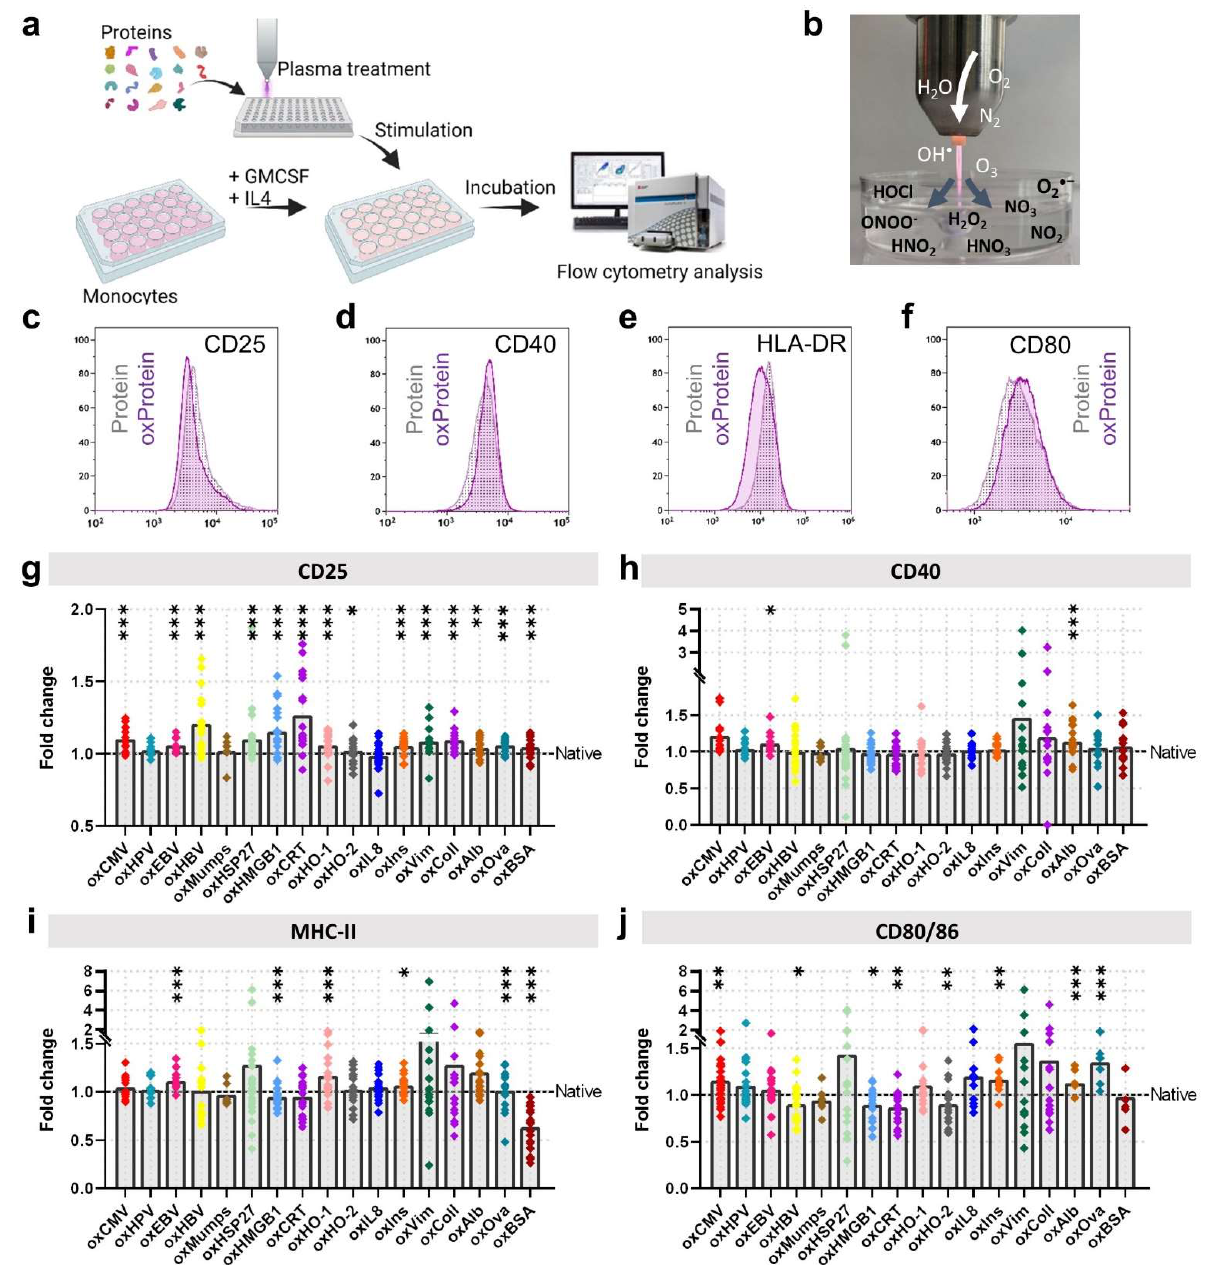
Figure 3. Gas plasma-oxidized proteins stimulate activation and maturation in phagocytes. ( a ) scheme of the experimental workflow; ( b ) gas plasma treatment of protein solutions; ( c – f ) repre- sentative histogram of surface marker expression of CD25 ( c ), CD40 ( d ), HLA-DR ( e ), and CD80 ( f ) investigated using flow cytometry 24 h after stimulation with proteins; ( g – j ) quantification of acti- vation marker CD25 ( g ), co-stimulatory receptor CD40 ( h ), maturation marker HLA-DR ( i ), and activation markers CD80/CD86 ( j ). Data are mean of six independent experiments, normalized to each corresponding native protein. Statistical analysis was performed using Mann–Whitney Test comparing each protein to its native (* = p < 0.05, ** = p < 0.01, *** = p < 0.001).